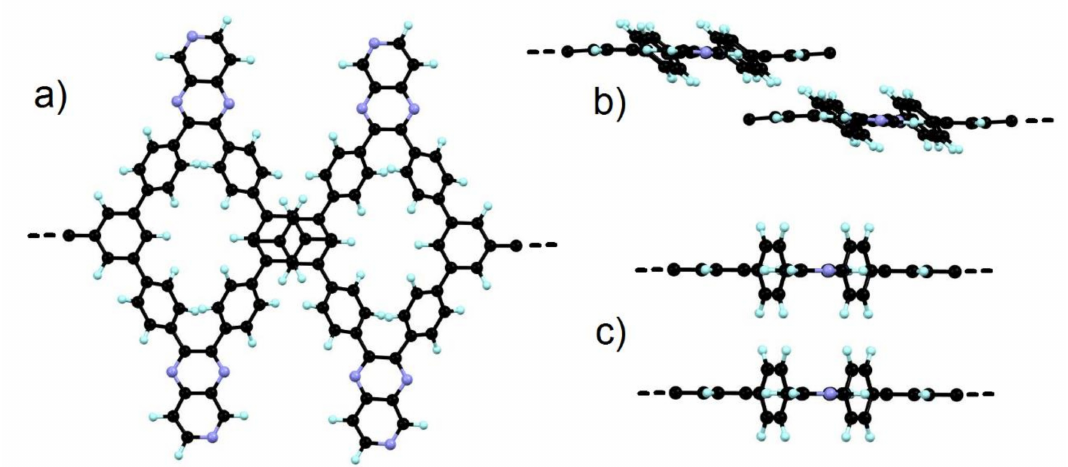
Figure 6. Atomic structures of ( a , b ) AB and ( c ) AA packing of the molecules within periodic boundary conditions. The bonds between the molecules in polymeric chains are shown by dashed